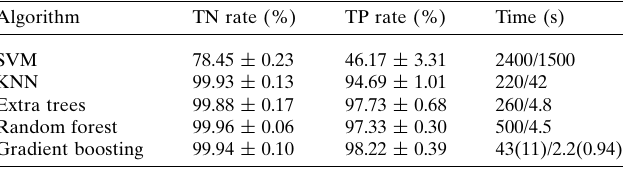
Table 4 Benchmarking results using the Nickel dataset. TN and TP rates represent the true negative and true positive rates evaluated with the Nickel test set. The training/testing time performances are measured with